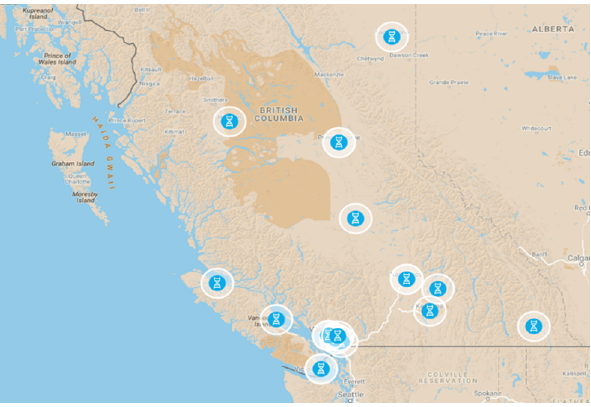
Figure 1. Map of participating pharmacies by their locations. For table of locations and pharmacies see Supplement SIX.